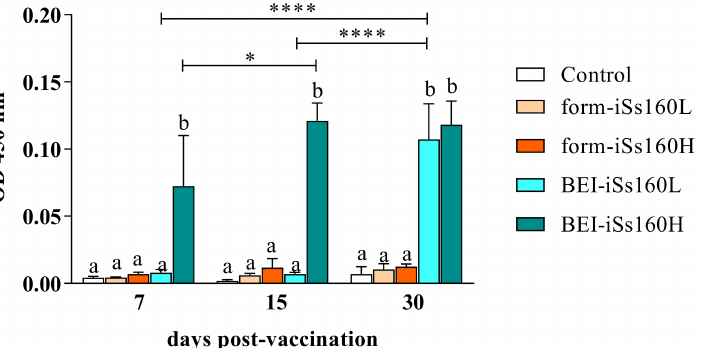
Figure 1. BEI-iSs160 vaccine induces specific humoral immunity. Specific anti-NNV IgM levels in the serum of Senegalese sole specimens 7-, 15- and 30-days after intraperitoneal vaccination with low and high dosages (10 5 and 10 7 TCID 50 /mL, iSs160L and iSs160H, respectively) of BEI-iSs160 vaccine (inactivated with BEI) and form-iSs160 (formalin inactivated) or PBS (Control). Data represent the mean ± standard error of the mean (SEM; n = 6 fish/group and time point). Lower letters denote statistical differences between groups at a same time-point ( p < 0.05), whilst asterisks indicate those between time-points in the same group (* p < 0.05; **** p <